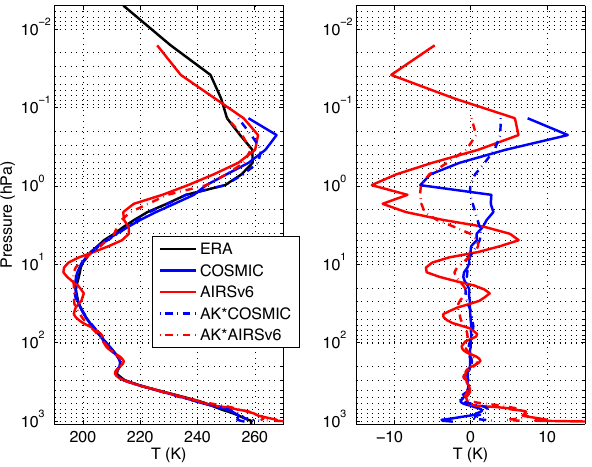
200 Figure 4. Antarctic May 2012 COSMIC/AIRS matchup mean ERA (black), COSMIC (blue solid), AIRS (red solid), AK*COSMIC (dashed blue), and AK*AIRS (red dashed) temperatures (left) and departures of these means from the ERA mean (right). AK* denotes application of the averaging